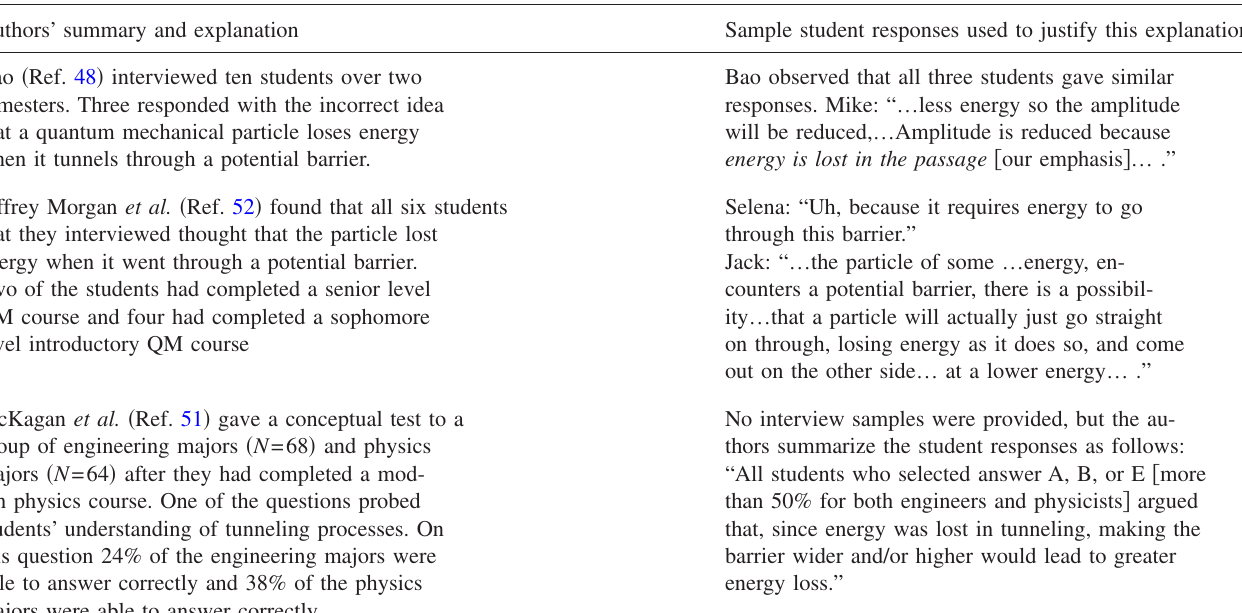
TABLE VI. Selected examples of the “exhaustion” misconception: Summary from three